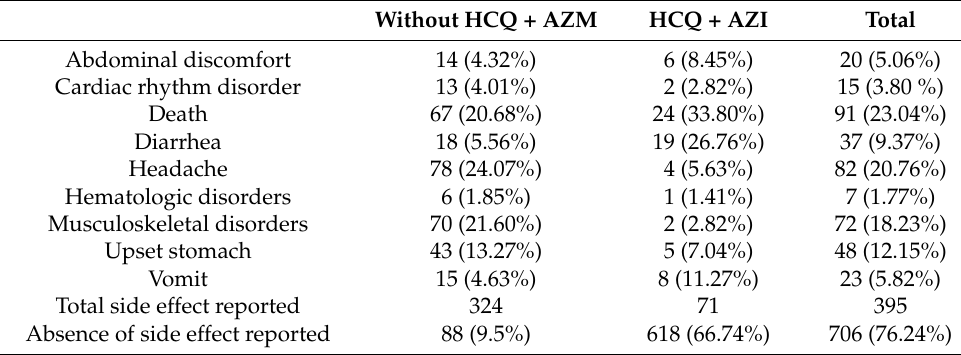
Table 2. Reported side effects in the two groups of